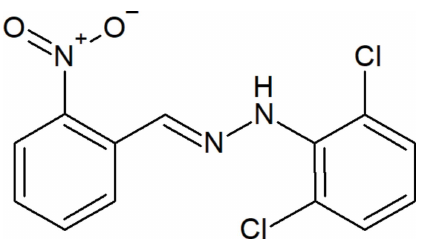
(cid:4) x , (cid:4) 1 (cid:4) z ; ( b ) + y , 1 2 2 2